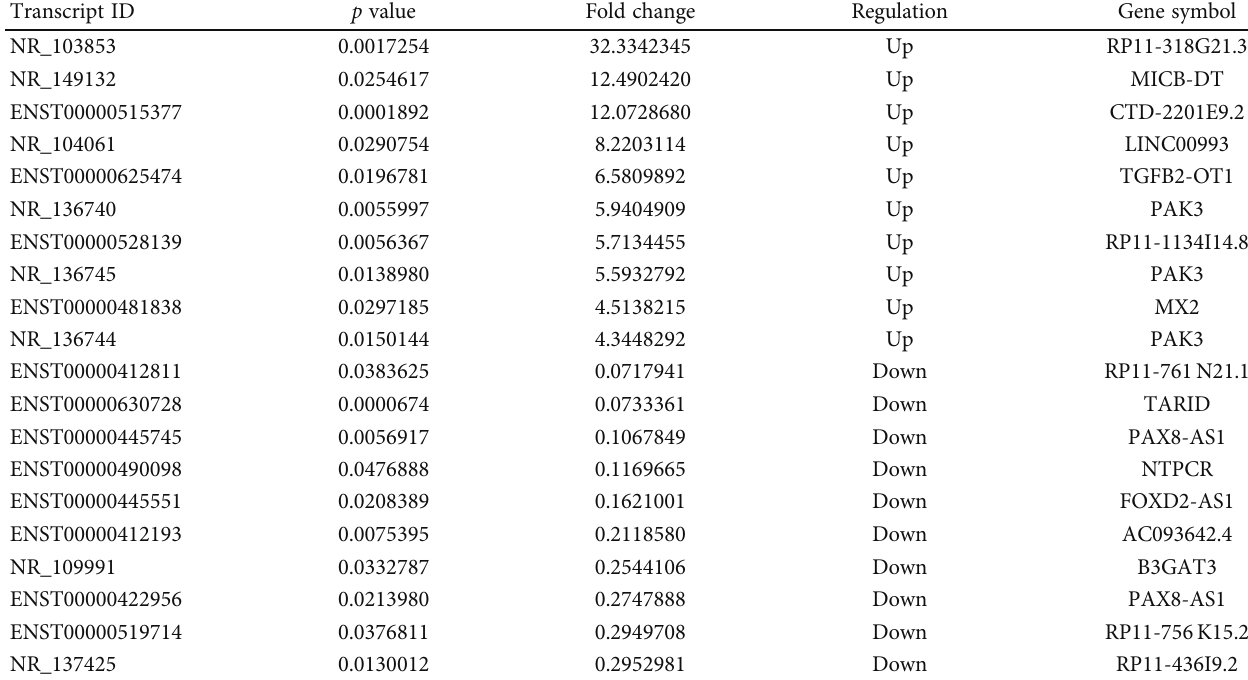
Table 2: The 20 most di ff erentially methylated lncRNAs in pPDLSCs under